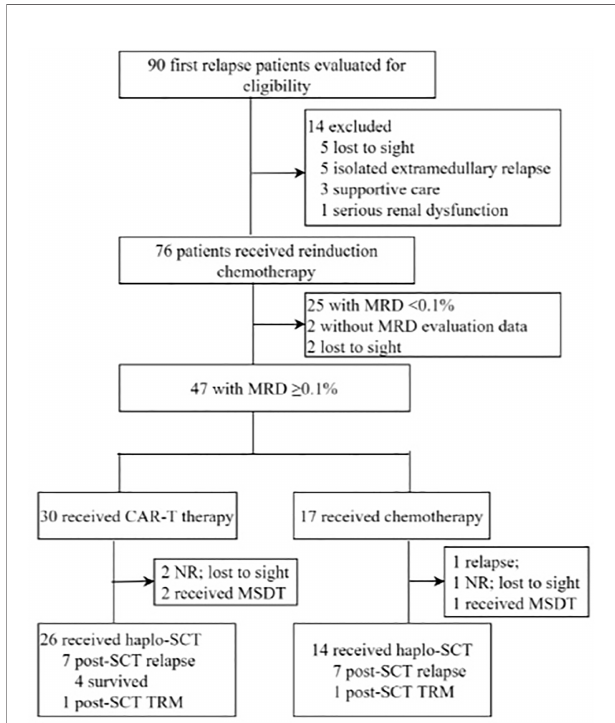
FIGURE 1 | Diagram of patients enrolled in this study. CAR-T, chimeric antigen receptor T cells; CR, complete remission; HSCT, hematopoietic stem- cell transplant; MRD, measurable residual disease; MSDT, matched siblings donor transplantation; NR, non-remission; TRM, treatment-related